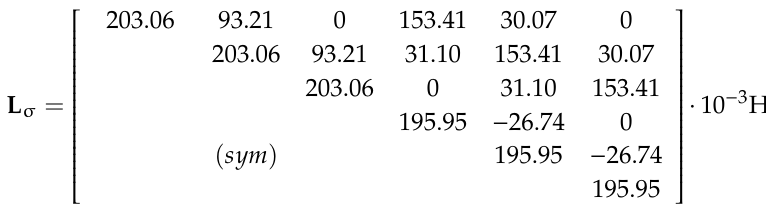
Figure 15. Components H x ( x , y ) and H y ( x , y )